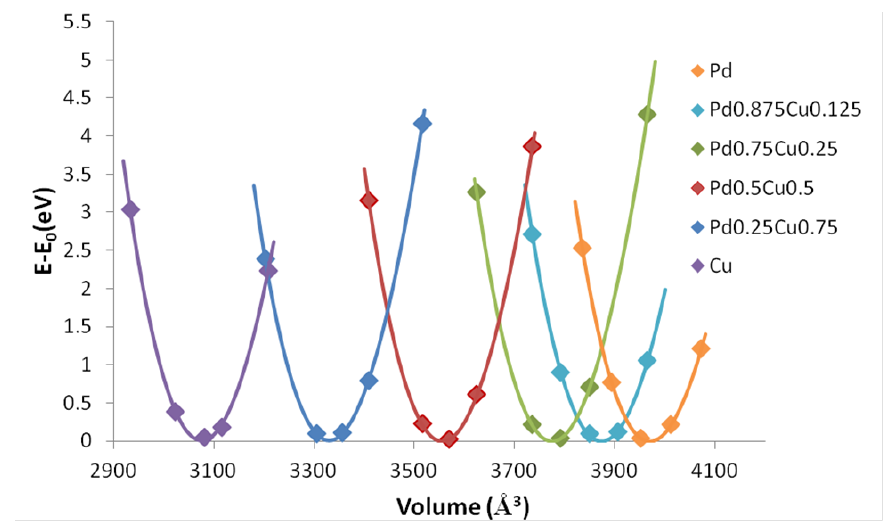
Figure 2. The total energy as a function of the super cell volumes and a Birch-Murnaghan fits to the calculated points for Pd